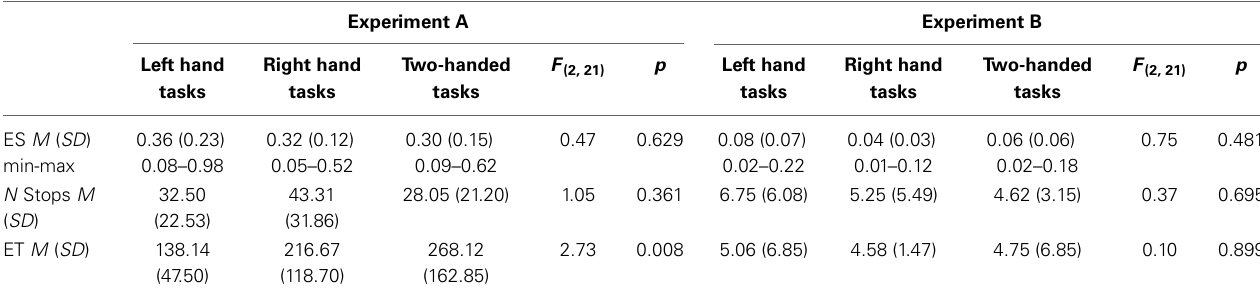
Table 1 | Descriptive data and ANOVA results of Experiment A (sunken reliefs) and Experiment B (common object